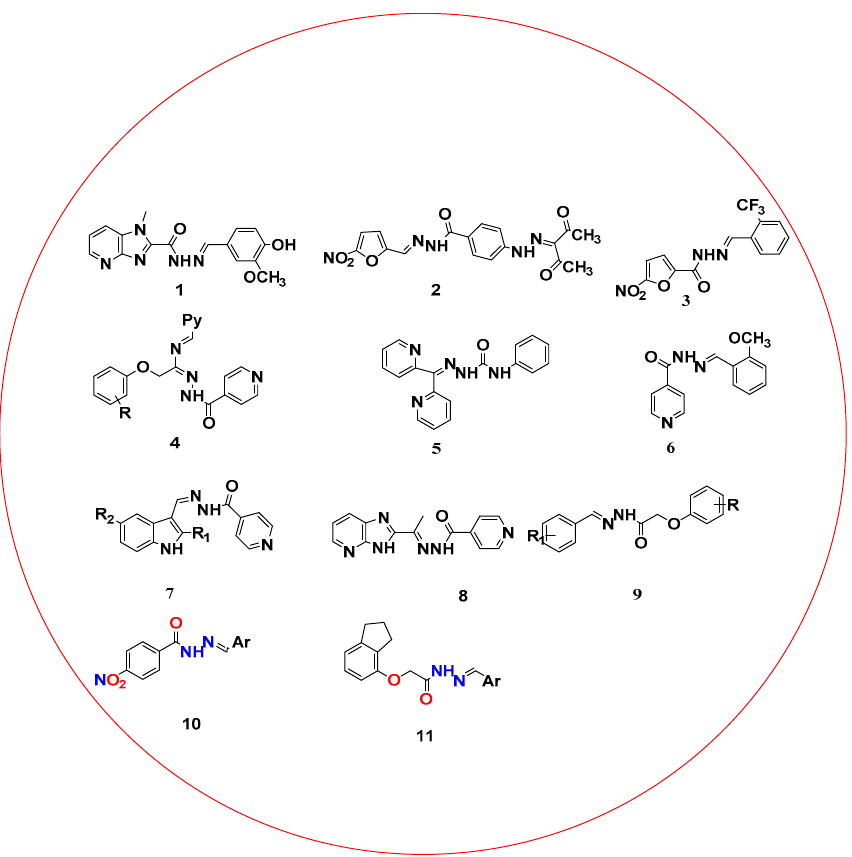
Figure 1. Schematic representation of some literature-reported bioactive molecules.